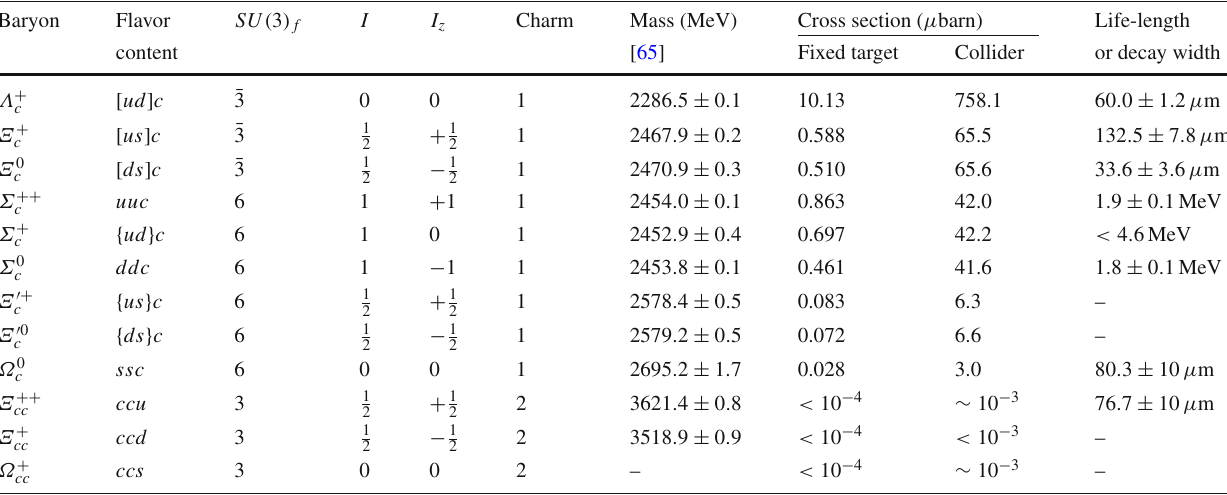
Table4 Propertiesofthesingleanddoublecharmedbaryons.Theanti- symmetric and symmetric in flavour functions are defined as [ q 1 q 2 ] ≡ 1